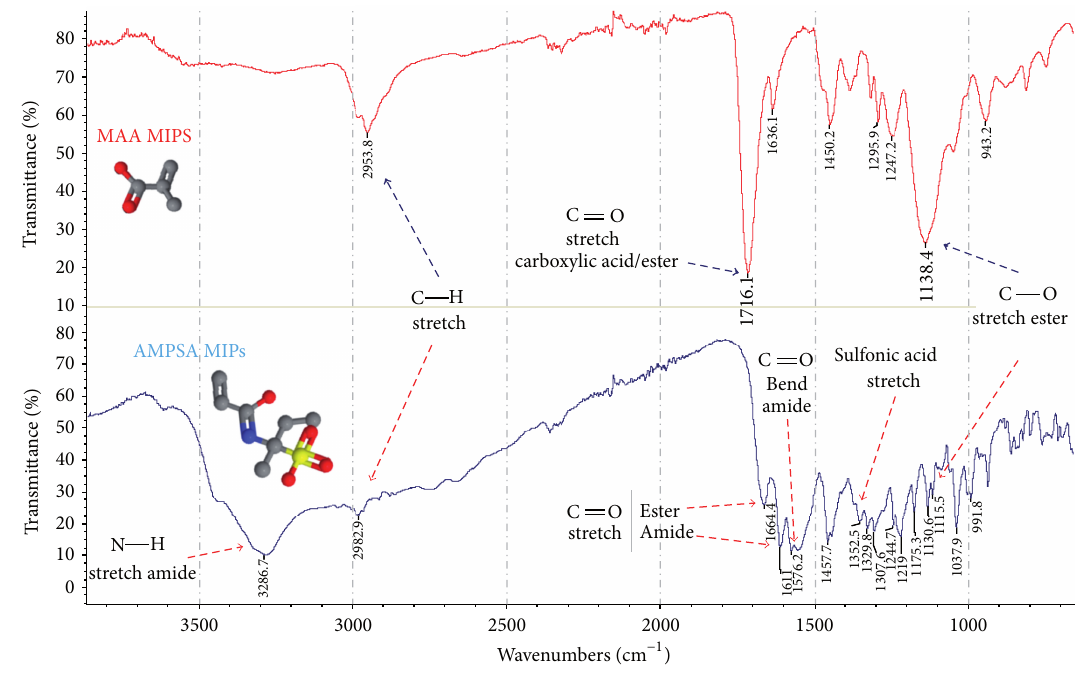
F 2: FITR spectra of the MAA- and AMPSA-based polymers. ATR accessory; number of scans: 32 scans; resolution: 4000.